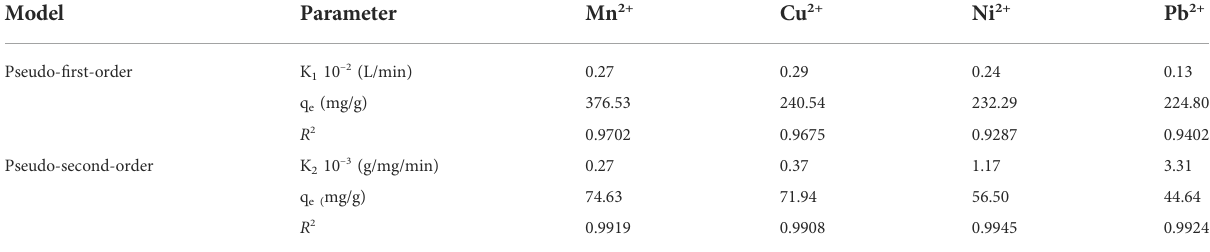
TABLE 4 Kinetic parameter models for four HMs by the MCFA